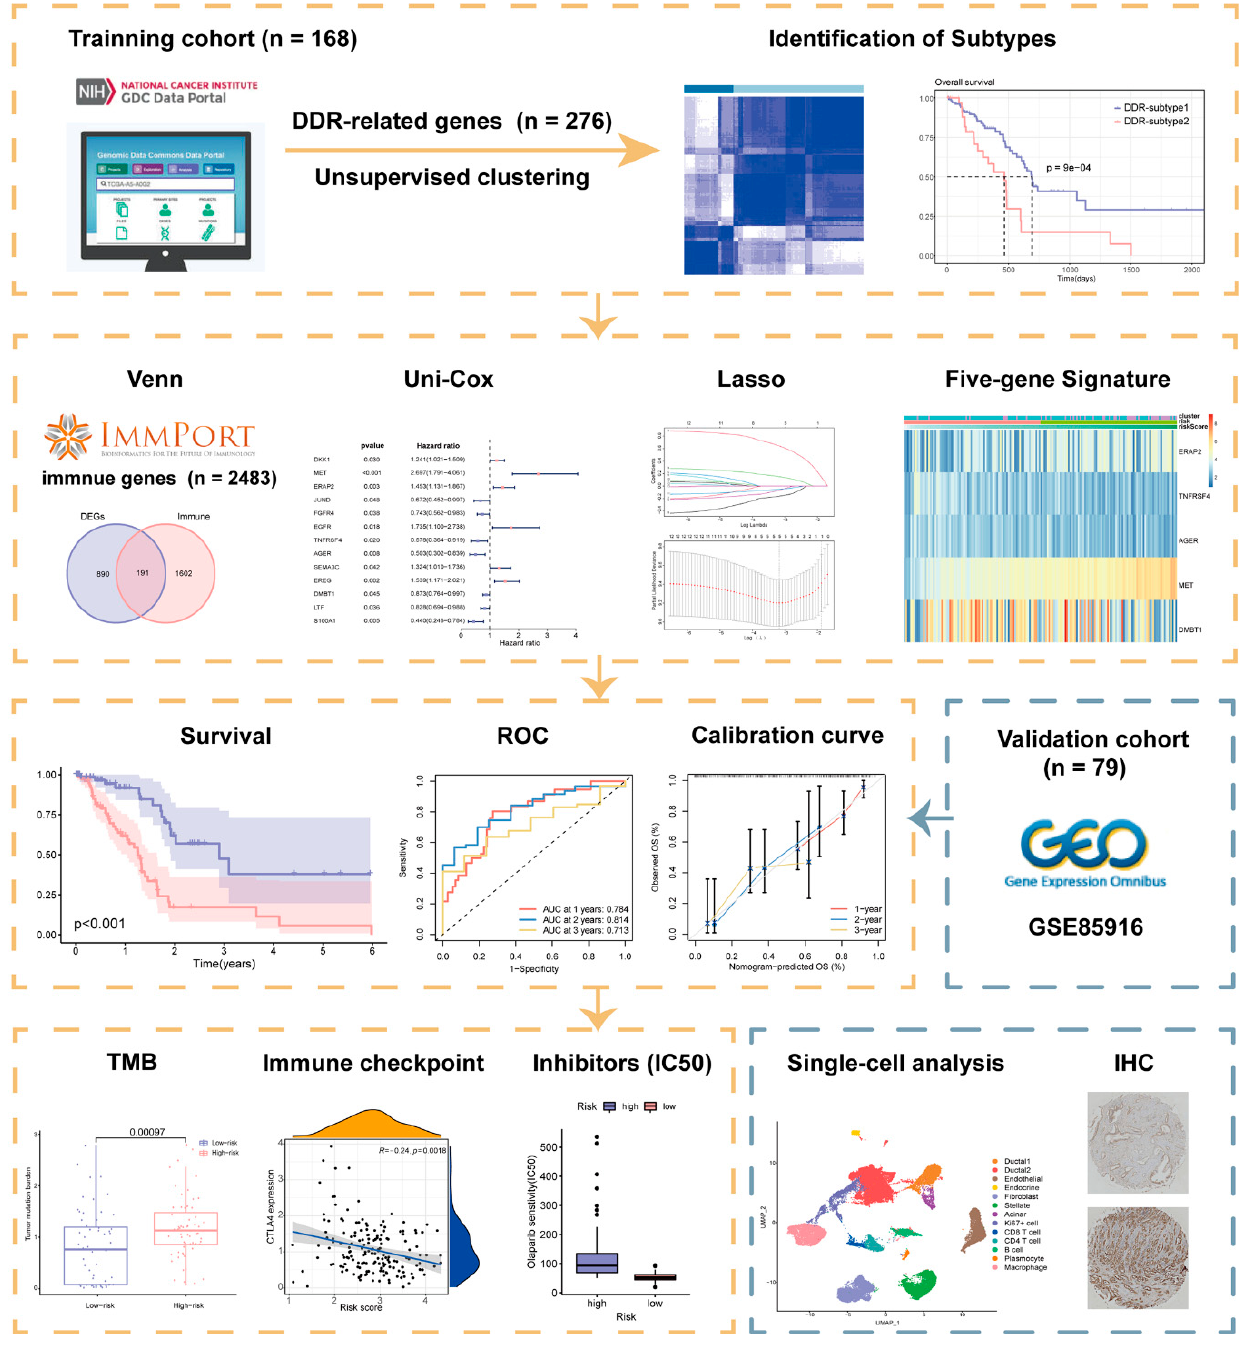
Figure 1. Workflow of the current study.